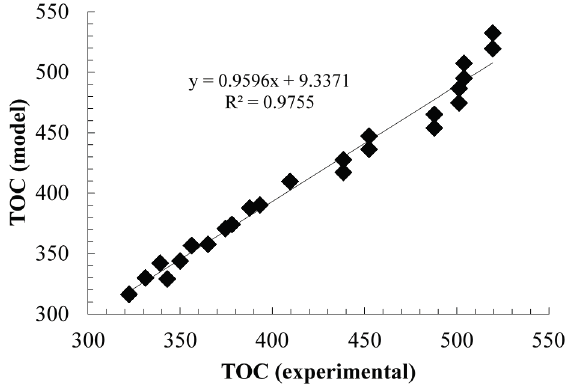
Figure 10. Comparison of the TOC values obtained by the model and the experimental TOC